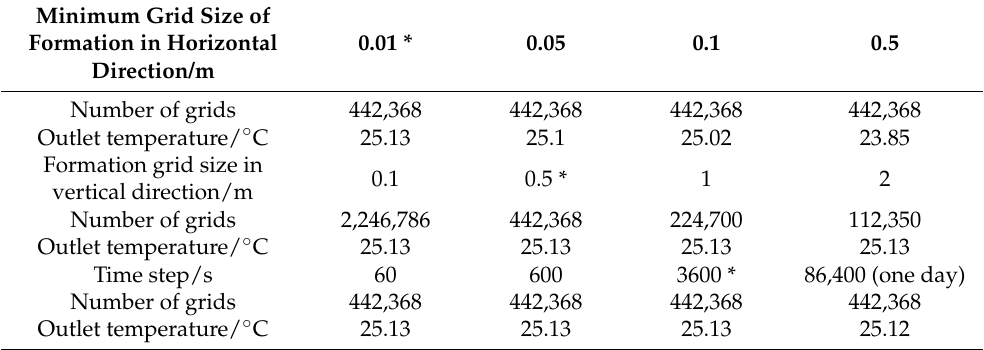
Table 2. Verification of model grid and time step